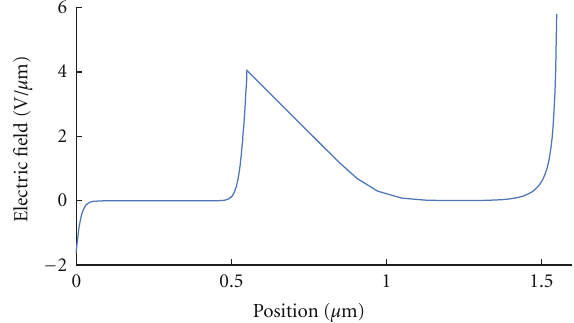
Figure 3: Electric field distribution in CdS/CdTe thin film solar